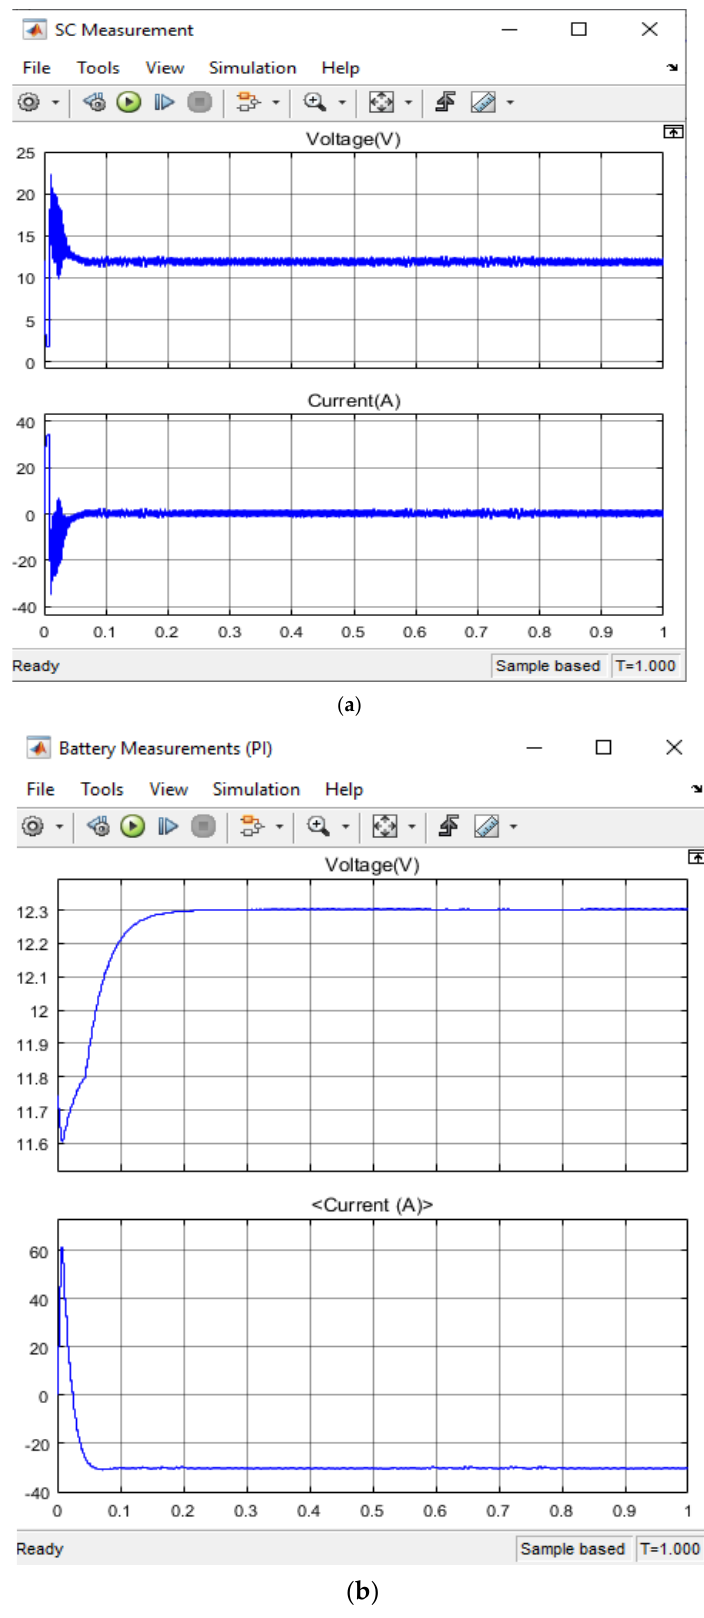
Figure 13. Voltage and current profiles for ( a ) supercapacitor and ( b ) auxiliary battery profile.